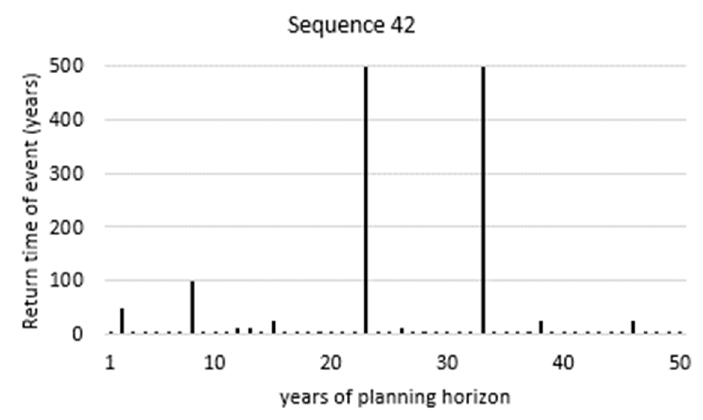
Figure 4. Example of random sequence of events 1–1000 return period.